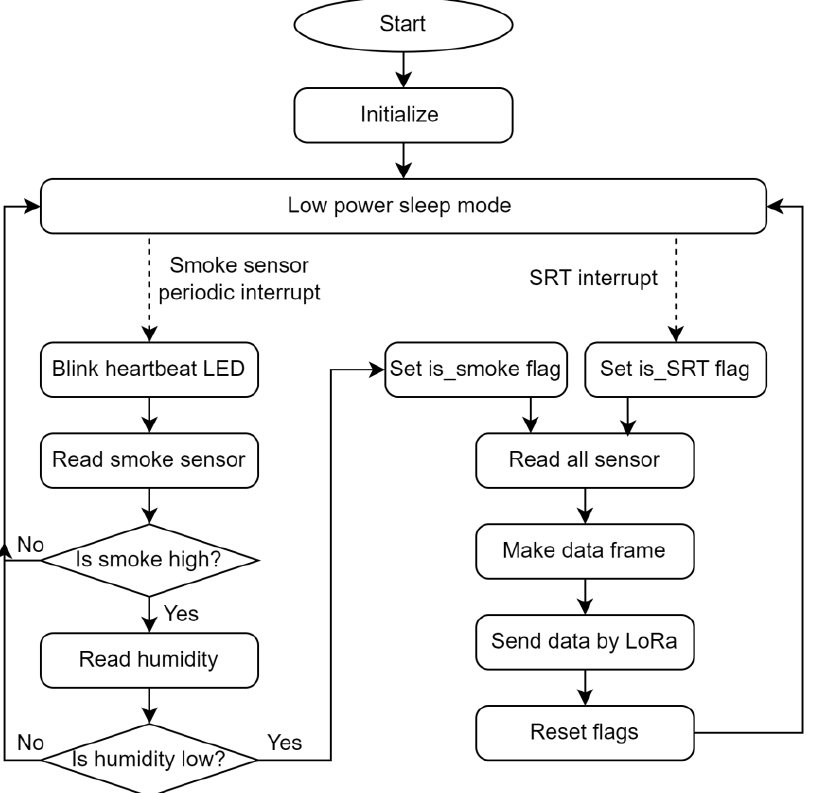
Figure 6. Flowchart of the sensor node